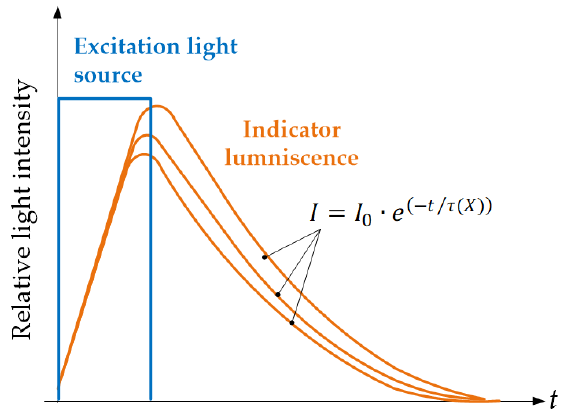
Figure 9. Dynamic response of a luminescent sensor to a pulse of